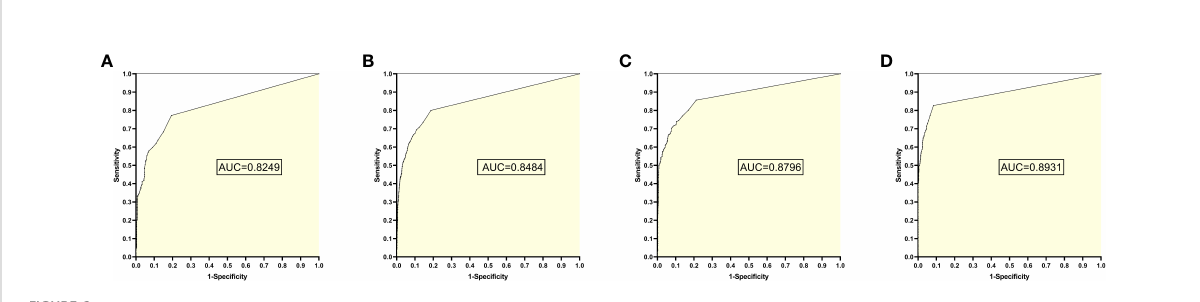
FIGURE 6 ROC curves and AUC values obtained by the training set 5 model testing each test set: (A) results from test set 1; (B) results from test set 2; (C) results from test set 3; (D) results from test set